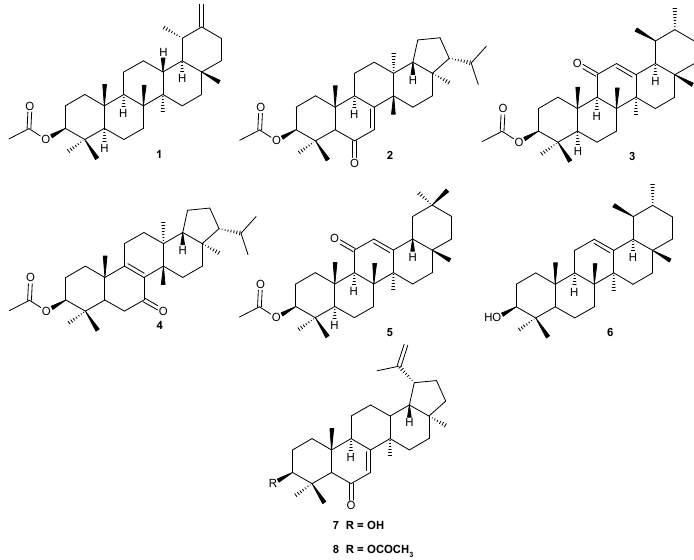
Figure 2. Structures of the triterpenoids 1-8.